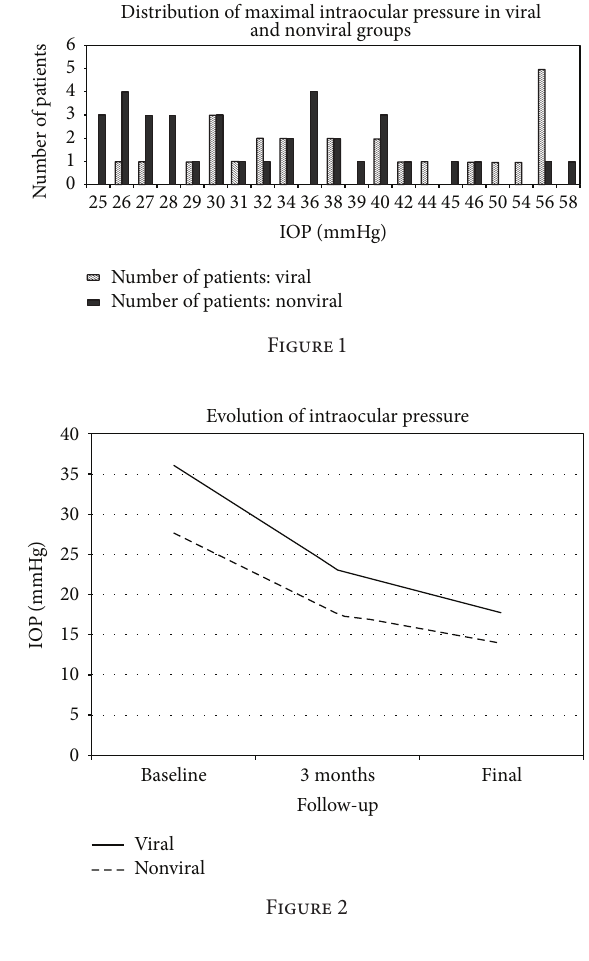
in 31 patients of the whole group 14 viral and 21 nonviral ( 𝑝 = 0.774